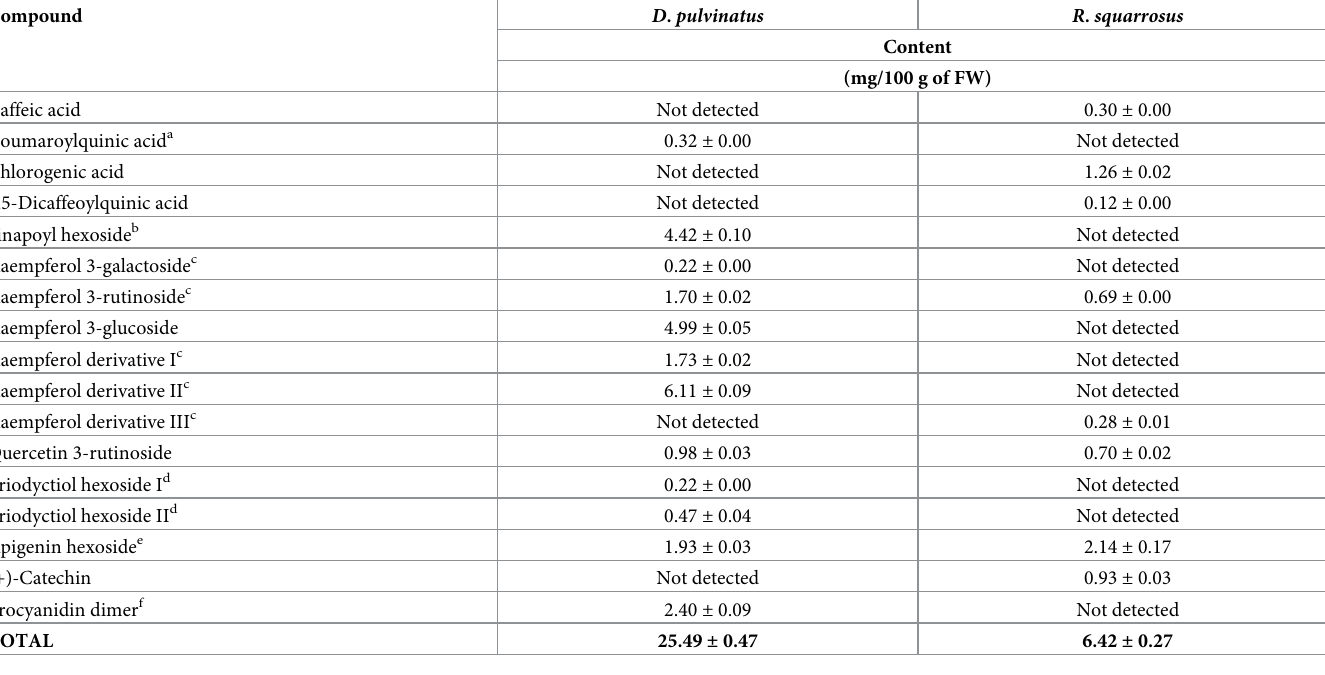
Table 4. Contents of identified phenolic compounds in the extracts of D . pulvinatus and R . squarrosus . Compound